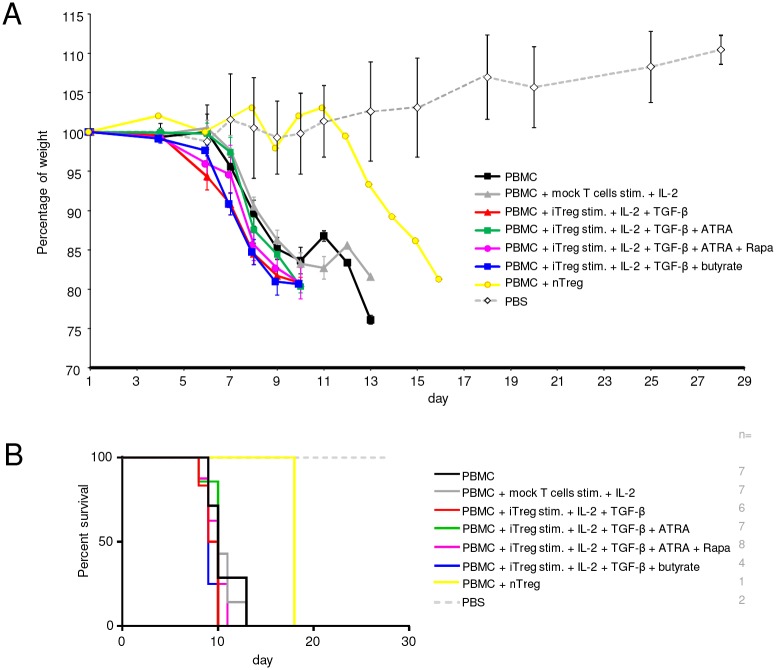
Analysis of suppressive function of human iTregs in vivo in xenogeneic GvHD.iTregs were induced 6 days under the indicated conditions, then washed and rested for 2 days. Allogeneic PBMCs were isolated and CD25-depleted the day before injection. NOG mice were irradiated and injected intravenously on the same day with 20x106 PBMCs alone or together with 5x106 iTregs or mock control T cells or expanded nTregs in PBS. As control, irradiated mice received PBS only. Mice were weighed every 1 to 3 days. (A) Shows percentage of mouse weight as mean +/- SEM for n = 4 to 8 mice per iTreg group combined from 2 independent experiments; mouse numbers (n) are indicated in the figure (B). (B) Shows the corresponding survival curves for the data from (A). There were no significant differences when comparing each iTreg group to either PBMC only or mock T cell groups.